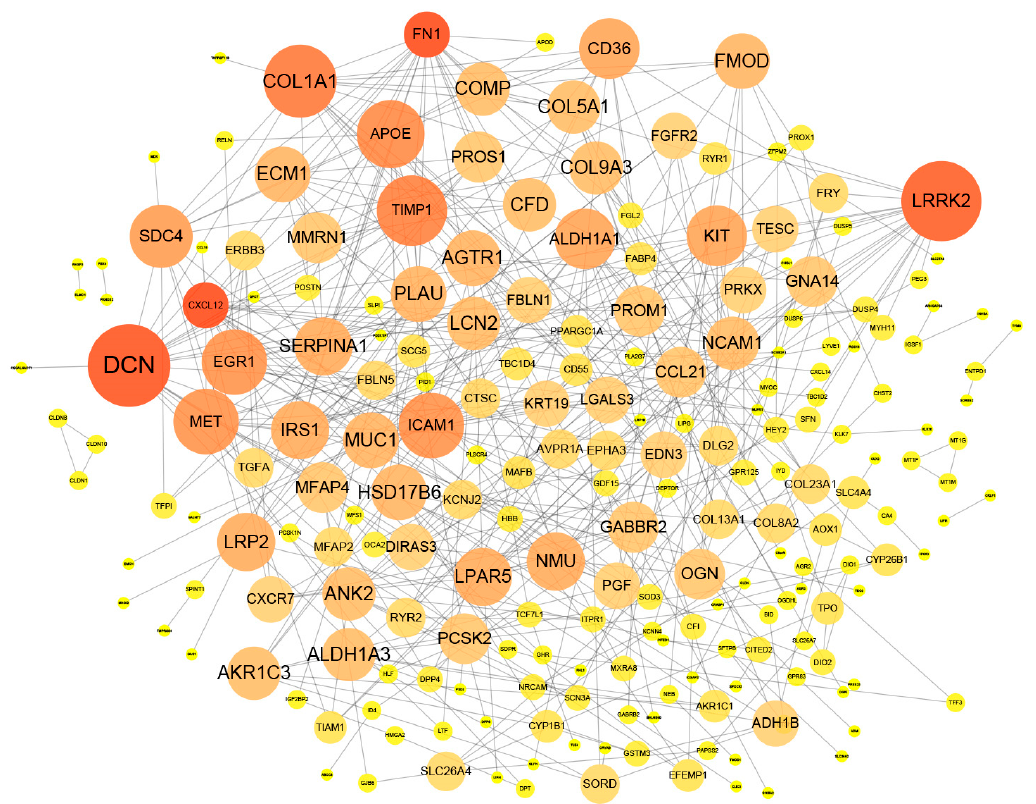
Figure 2. Interaction network of DEGs. The size and color of the node represent the importance of the node. The larger the node and the redder the color, the more neighbors are connected to the node.